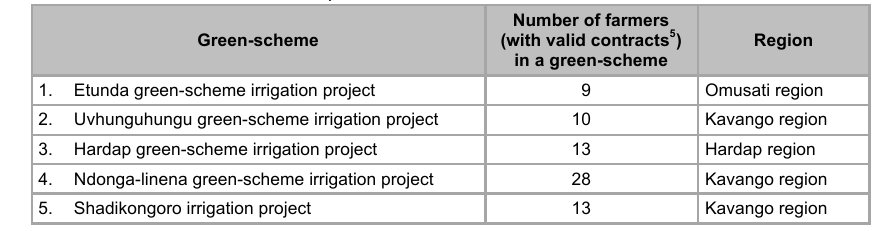
Population list of Green-schemes Green-scheme